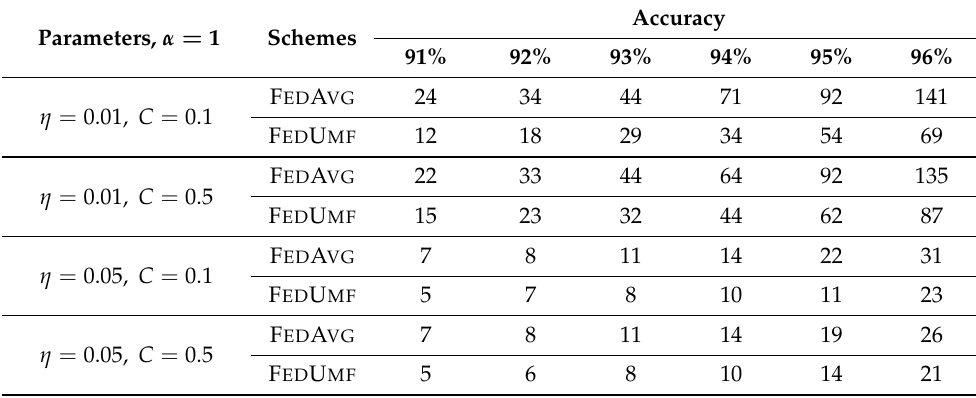
Table 2. Accuracy on MNIST dataset, Non-IID